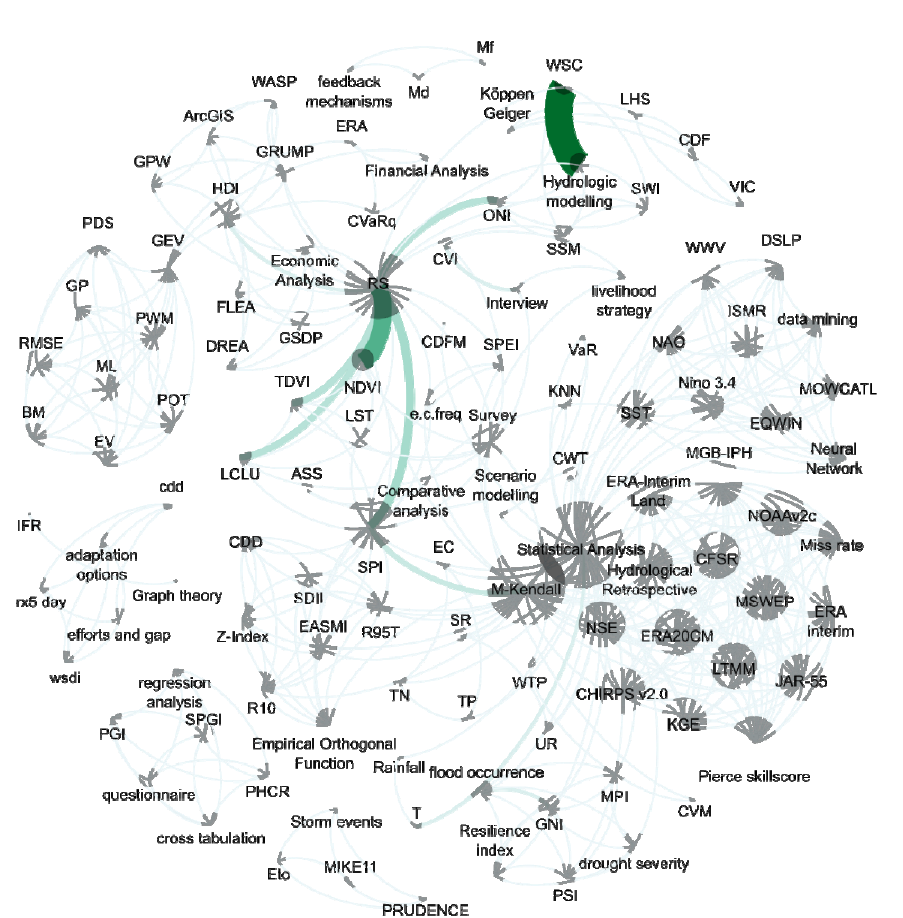
Figure 3. Methods and indices used in the investigated studies to define and evaluate subjects relating to flood and drought.